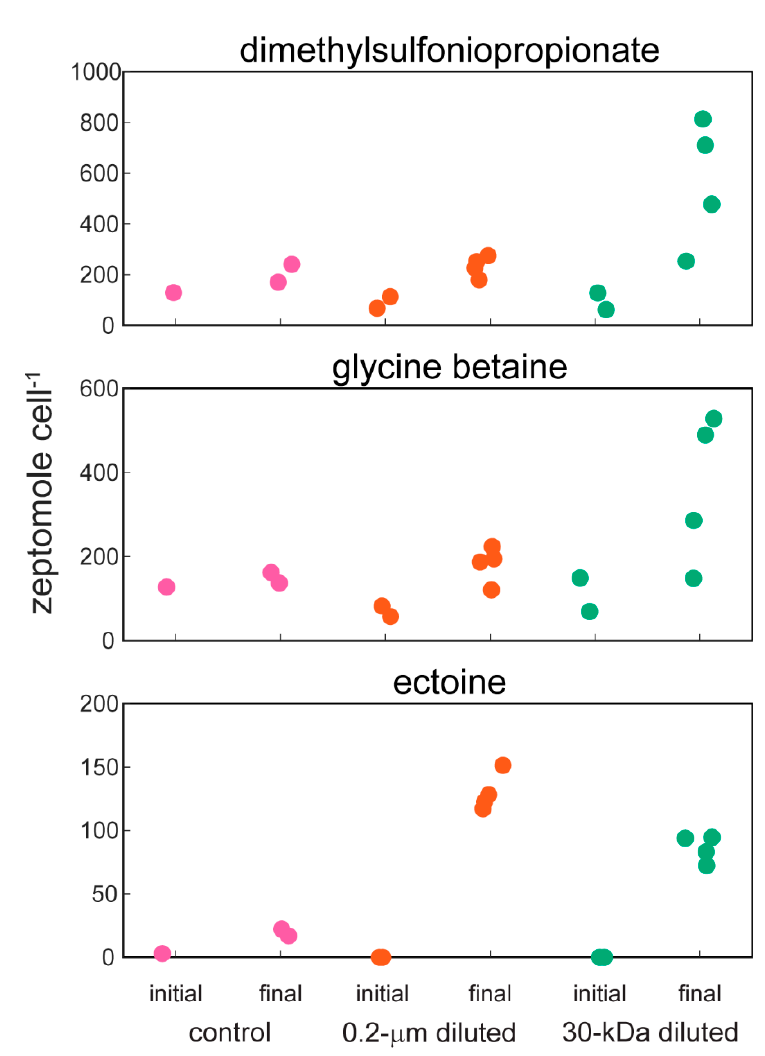
Figure 3. Cell-specific glutamic acid concentrations at the initial and final time points of experiment. Glutamic acid is one of the amino acids measured with the targeted metabolomics method used in this project. The remaining amino acids are plotted in Supplemental Figure S3.